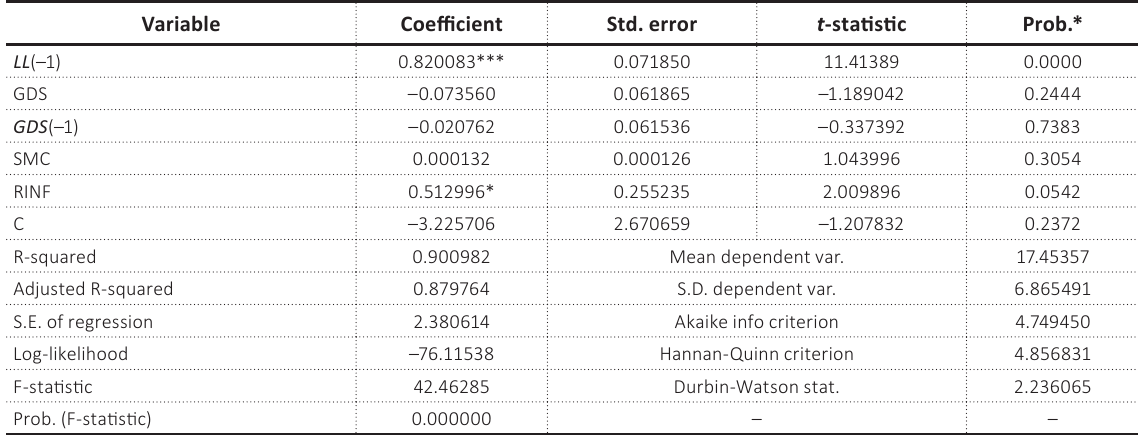
Table 4. ARDL model for liquid liabilities and finance for growth